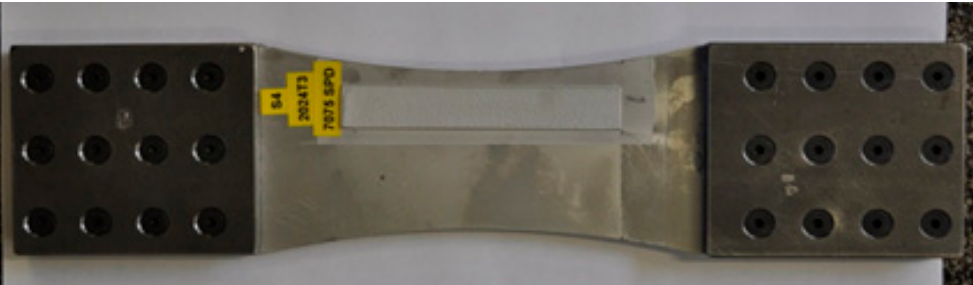
Figure 22. Location of the 7075 SPD strip on the 2024-T3 specimen.